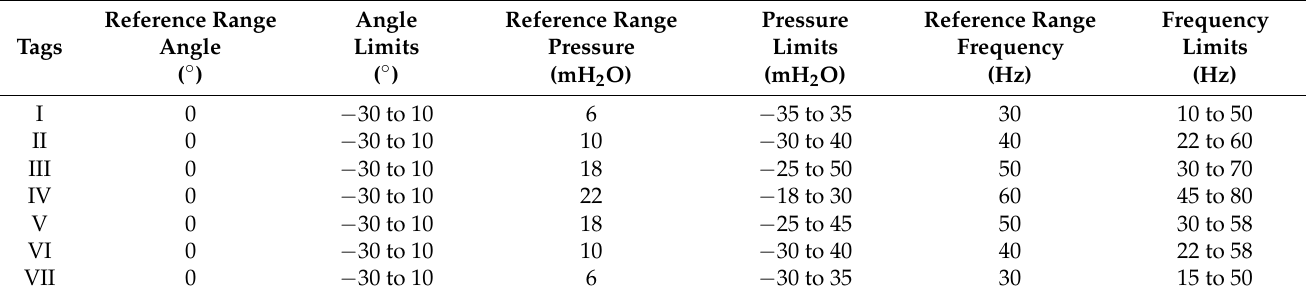
Table 7. Noises inserted into the soft sensor inputs: testing B.